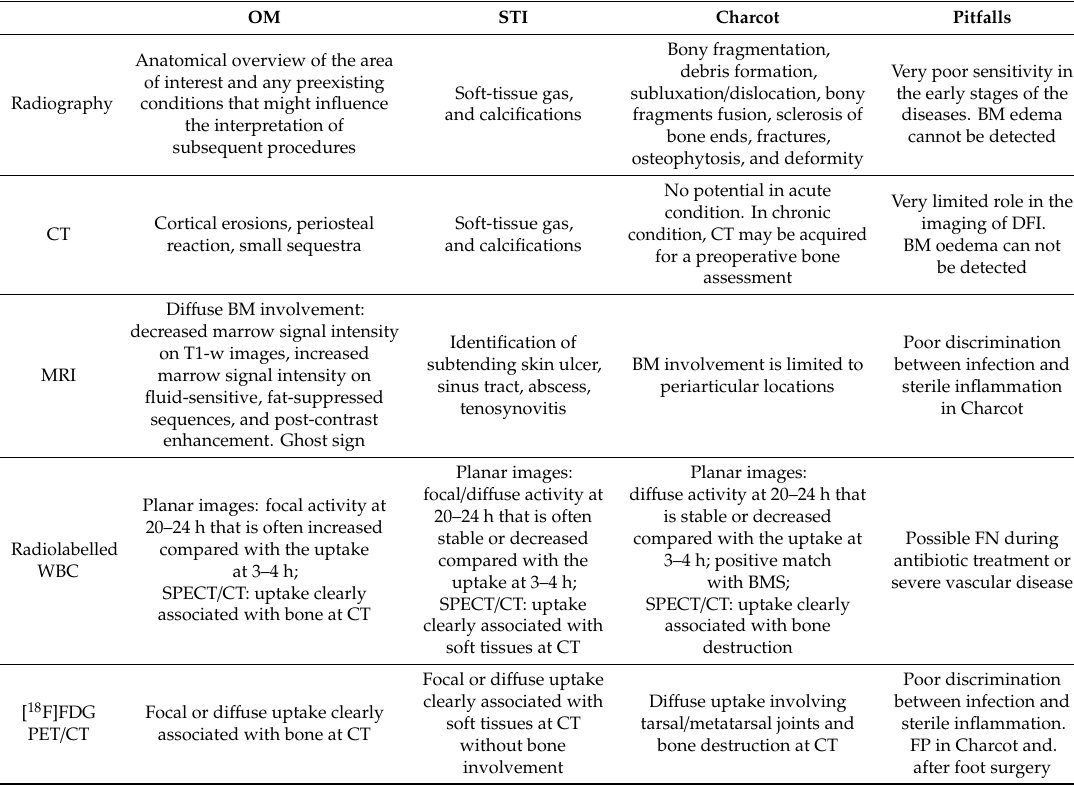
Table 1. Common interpretation criteria of di ff erent imaging modalities in diabetic foot infections. OM STI Charcot